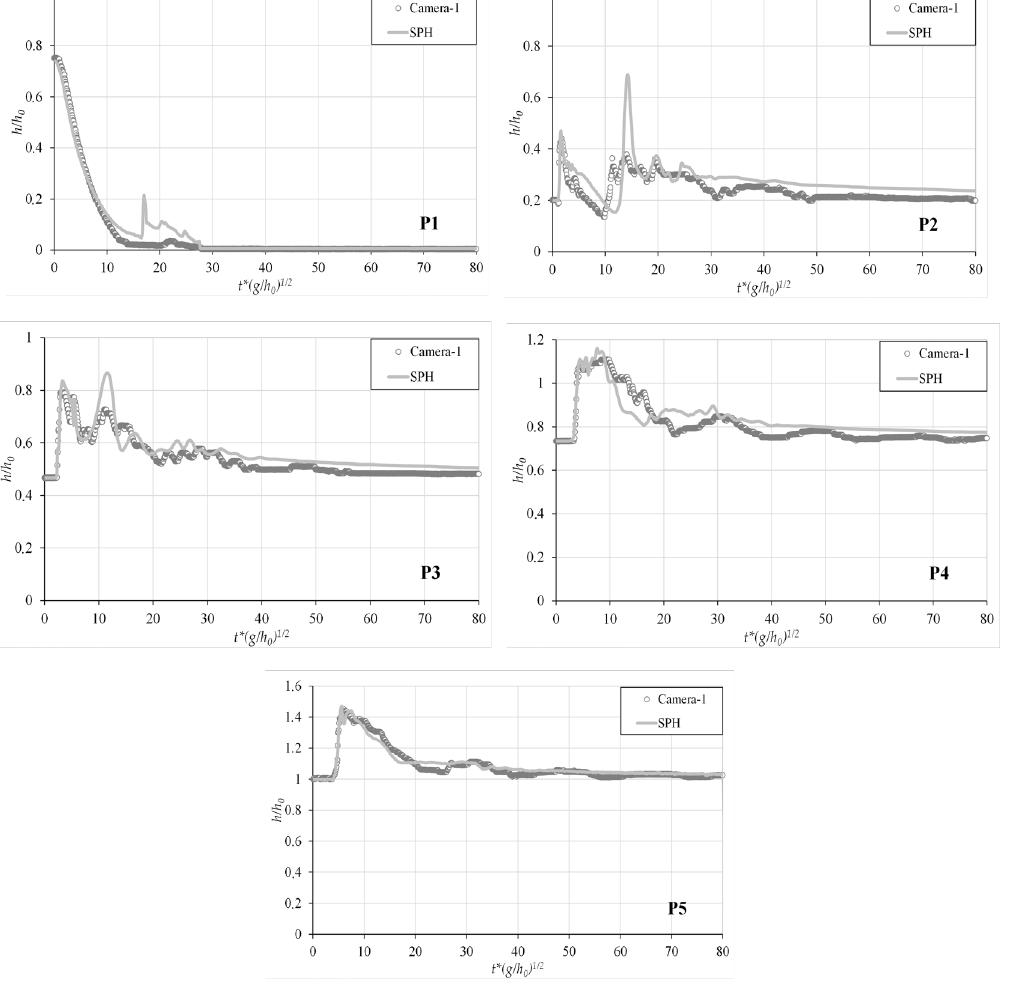
Figure 13. The comparison of the experimental and numerical results through stage hydrographs.